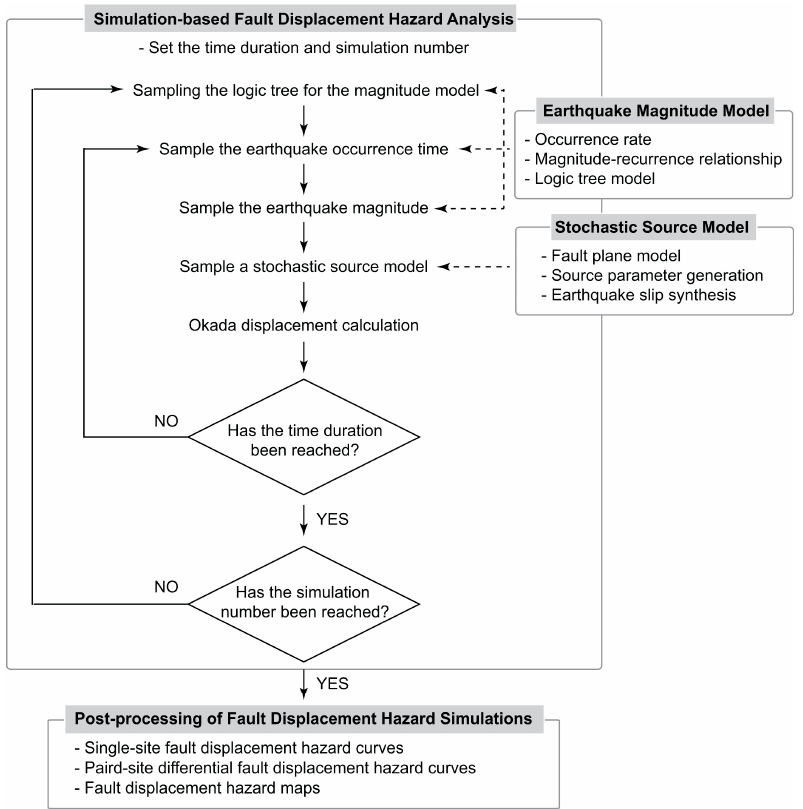
Figure 1. Flowchart of the fault displacement hazard analysis based on the stochastic source modeling method.